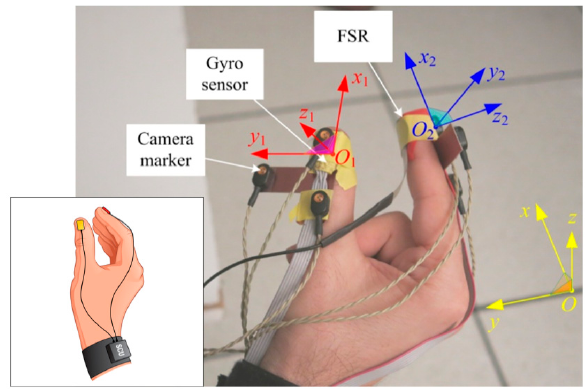
Figure 1. Sketch of the inertial sensor system showing sensors connected to sensor control unit (SCU), and photo of the experimental setup: gyro sensors, camera markers, and FSR sensor mounted on thumb and index finger, global Cartesian coordinate system ( x , y , z ), and local coordinate systems of the thumb ( x 1 , y 1 , z 1 ) and index finger ( x 2 , y 2 , z 2 ).